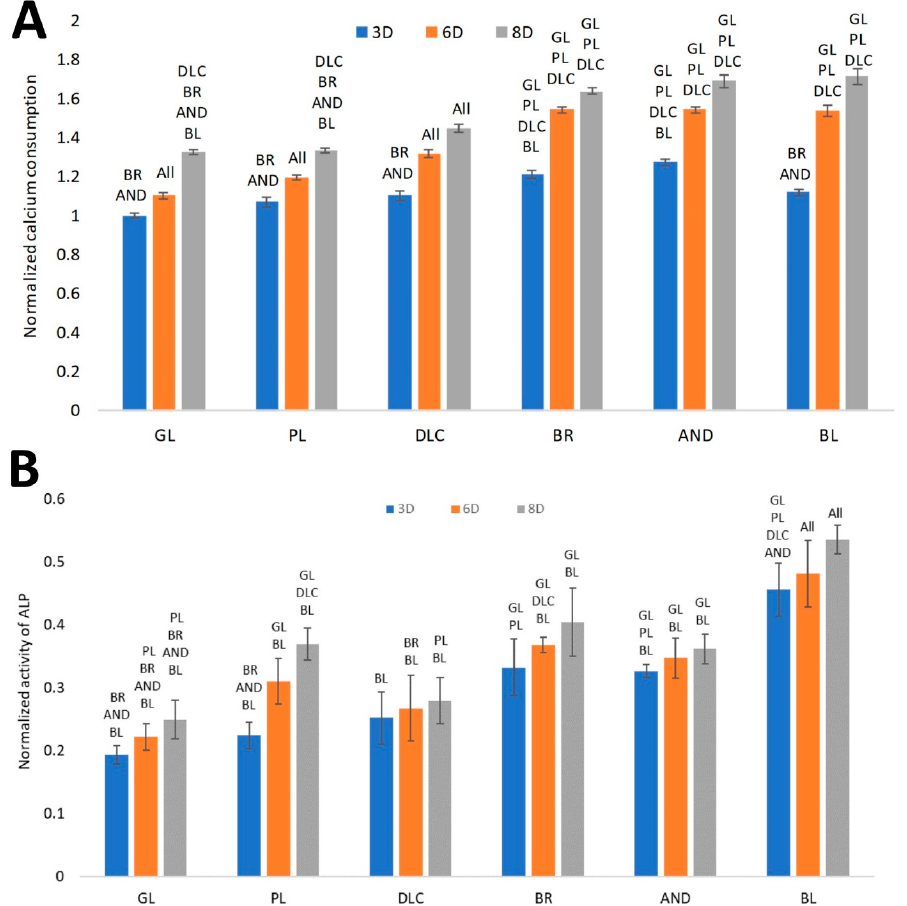
Figure 9. ( A ) Consumption of calcium from the culture medium by cells on the reference glass coverslips (GL) and on the Ti6Al4V samples modified by polishing (PL), by DLC-coating (DLC), by brushing (BR), by anodizing (AND), or by blasting (BL), estimated by the calcium depletion from the culture medium on days 3, 6, and 8 of cell cultivation. ( B )Activity of ALP on the samples. Average ± SD from eight samples, ANOVA, statistical significance (p ≤ 0.05).